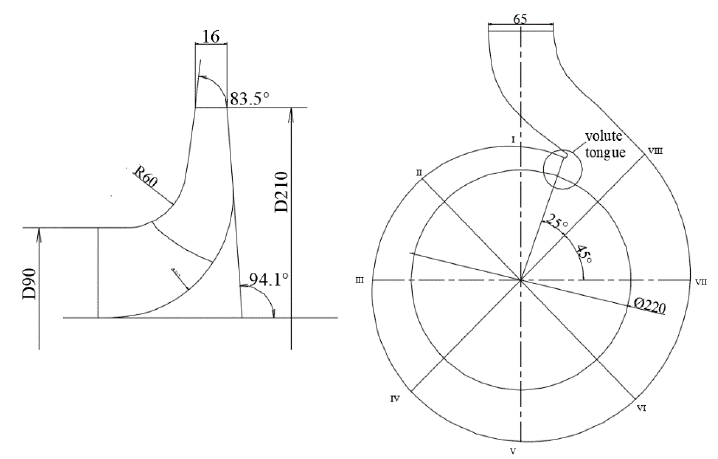
Figure 2. A real application of turbine.